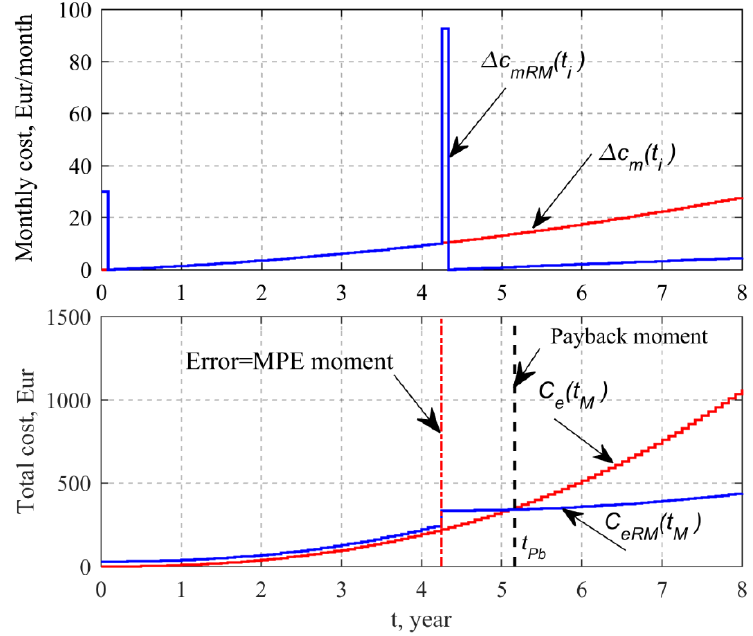
Figure 3. Monthly cost increase (upper subplot) and accumulated cost (bottom subplot) due to meter error (red line) and meter error with included remote monitoring and replacement (blue line).